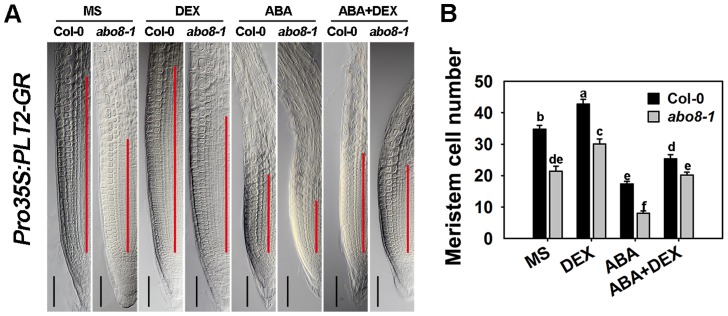
The sensitivity of abo8-1 roots to ABA is partially rescued by the expression of the inducible Pro35S:PLT2-GR.A. The length of the root meristem (red line) of wild-type (carrying Pro35S:PLT2-GR) and abo8-1 (carrying Pro35S:PLT2-GR) seedlings on MS medium or MS medium supplemented with DEX, ABA, or ABA plus DEX. Bars = 50 µm. B. Root meristem cell number of the wild type (Col-0) and abo8-1 in (A). Three independent experiments were done with similar results, and each experiment had three replicates. About 20 roots were measured for each replicate. Values are means ±SE from one experiment. Means with different letters are significantly different at P<0.01.